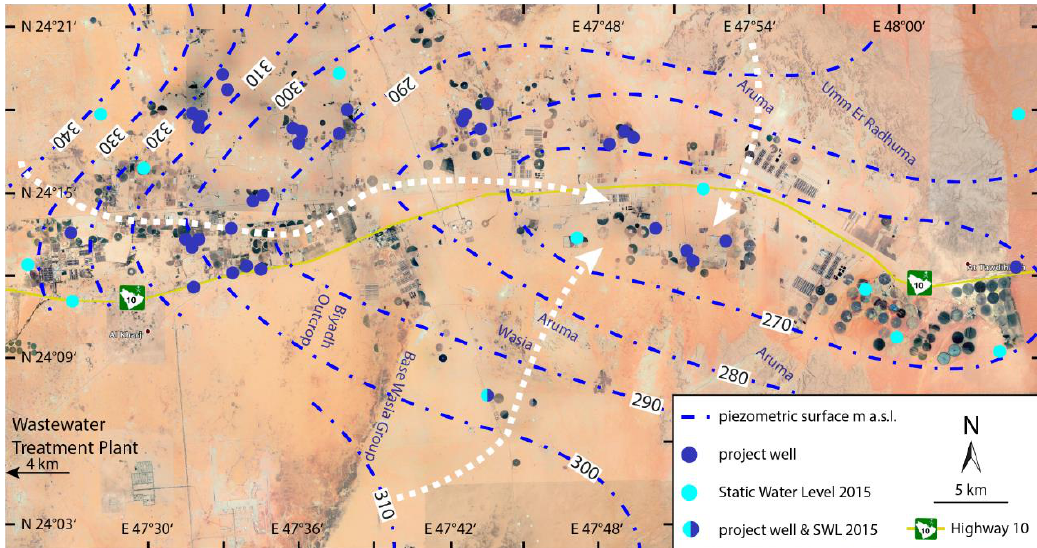
Figure 4. Google Earth map of the study area with sampled wells (dark blue dots) and piezometric heads as of 2015 (updated and modified from Reference [16]). Light blue dots indicate sites of static water level with performed water level measurements. Light blue/dark blue dots represent sampling and piezometric well sites. White, dashed lines are groundwater flow directions. Also shown are some major outcrop areas with dark grey to green colored radial-shaped irrigation areas (center pivots) and the position of the wastewater treatment plant south of Al Kharj.